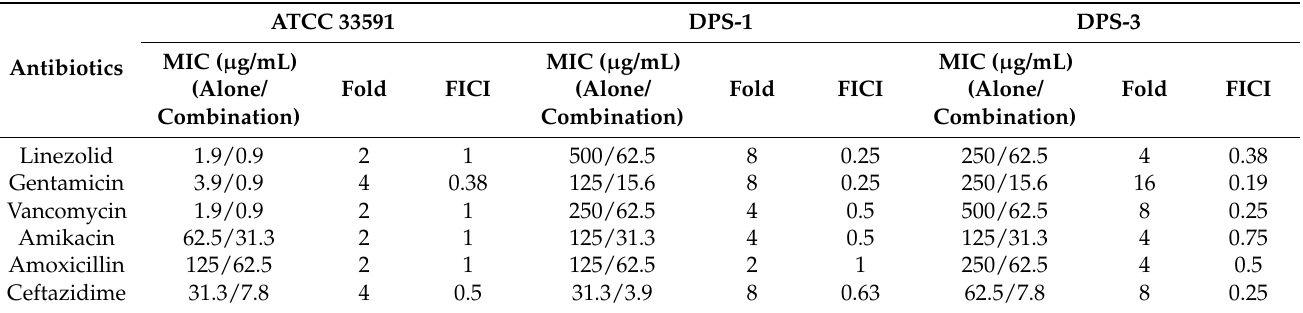
Table 1. Synergistic effect of SGB combined with conventional antibiotics and the MIC of antibiotics used alone or